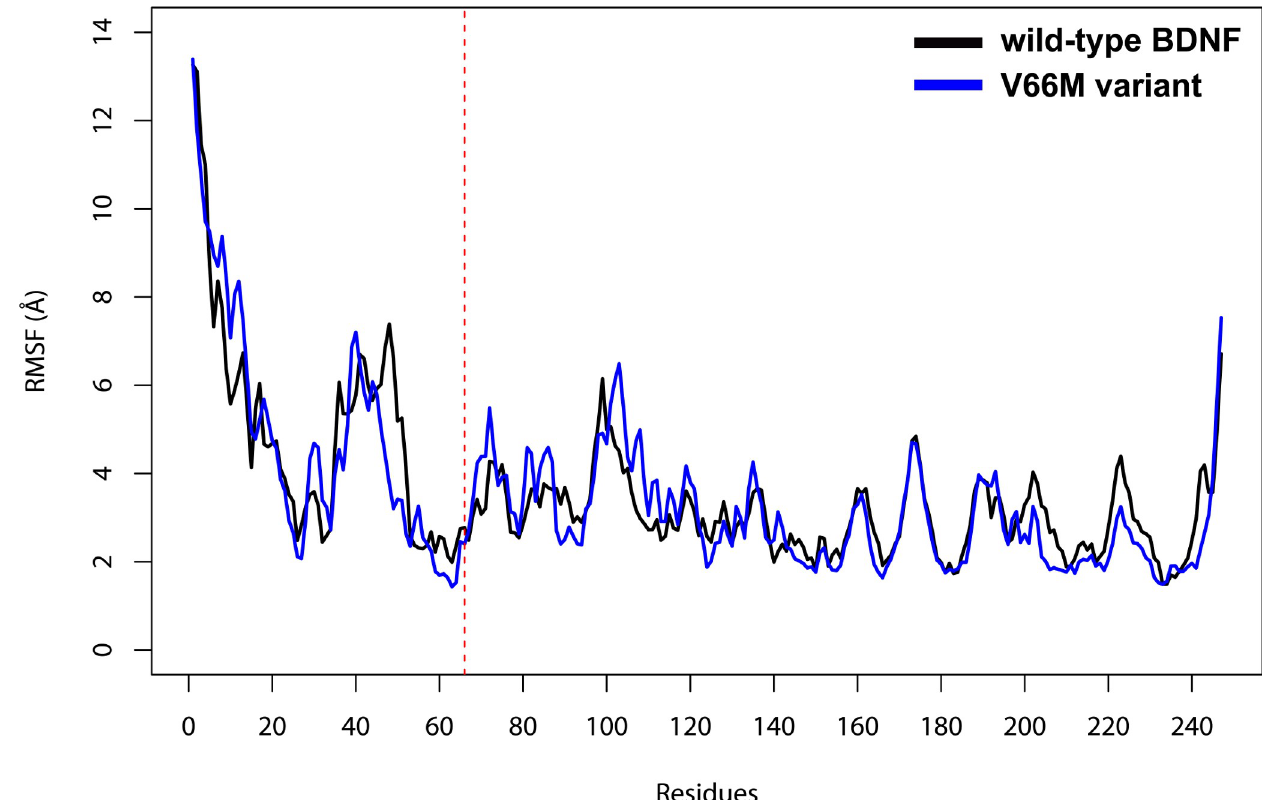
Fig 9. RMSF of wild-type BDNF and its V66M variant. RMSF of each residue of wild-type BDNF (black) and its V66M variant (blue) at 300 K are shown as a line plot. The dashed red line shows residue 66.